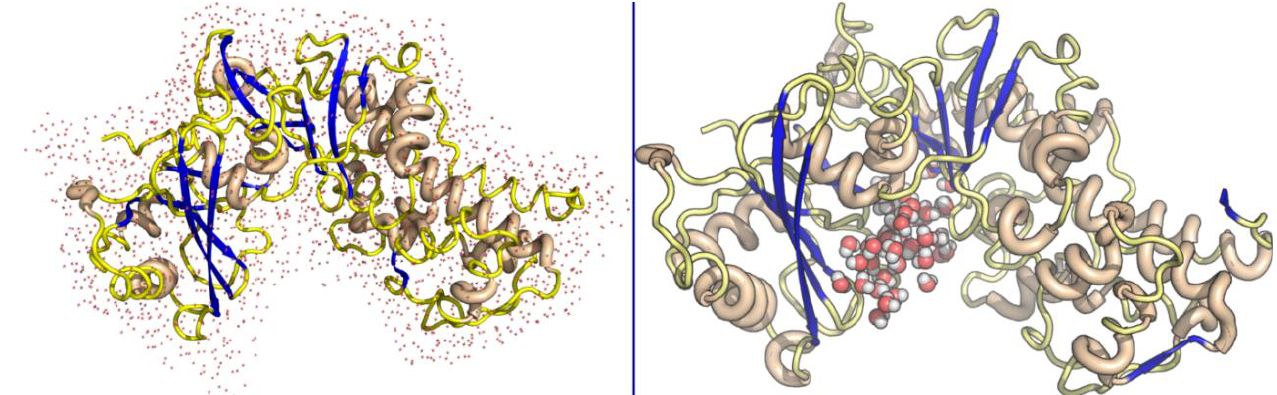
Figure 5. The RMSD of protein and ligand over the MD simulation time.